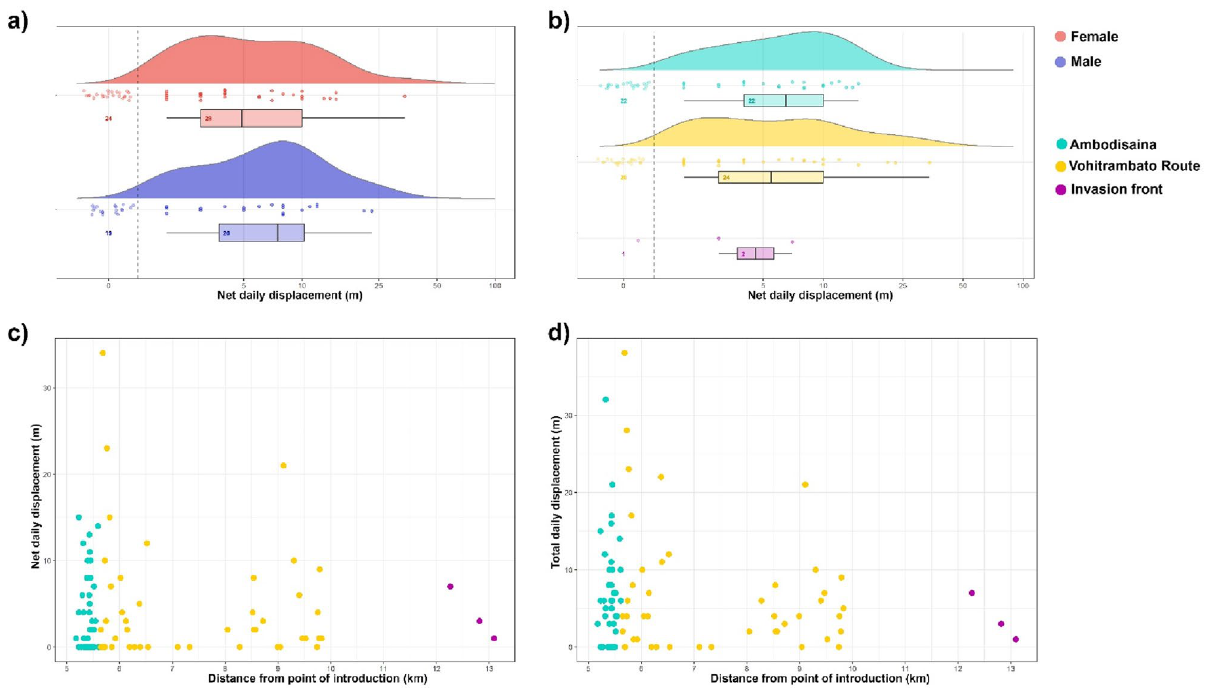
Figure 3. ( a ) Frequency distribution of daily movements of 72 Asian common toads (the individuals for which daily movements were available) in Toamasina (Madagascar), divided by sex (females = red, males = blue) and ( b ) locality (Ambodisaina = sky blue, Vohitrambato Route = yellow, Invasion front = purple); ( c ) scatterplot of net daily displacement of tracked toads in relation to the distance from the introduction point; ( d ) scatterplot of total daily displacement of tracked toads in relation to the distance from the introduction point, Colors in panel ( c ) and ( d ) indicate the different localities, such as in panel ( b ). Box and density plots are plotted excluding non- movements. The number of daily movements used to create the boxplot is indicated within the boxplot. R code used to obtain this plot was modified from Hodges et al. 55